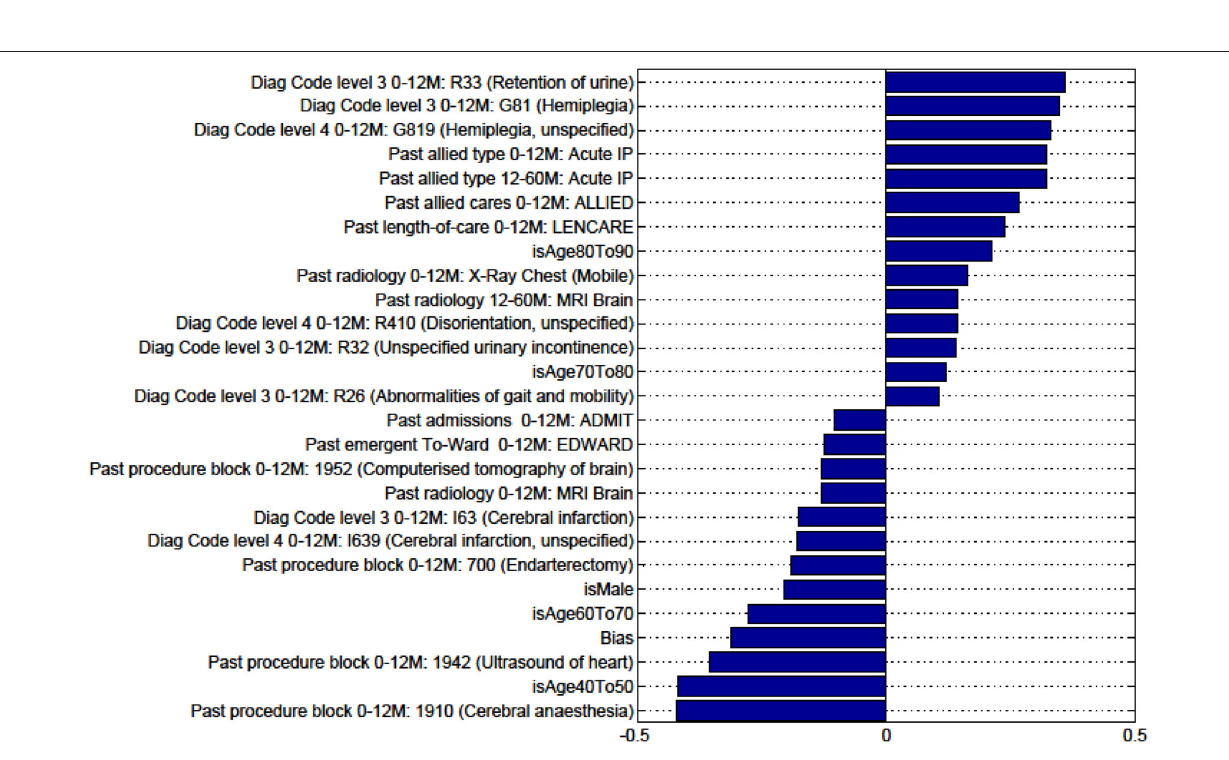
Frontiers in Neurology |